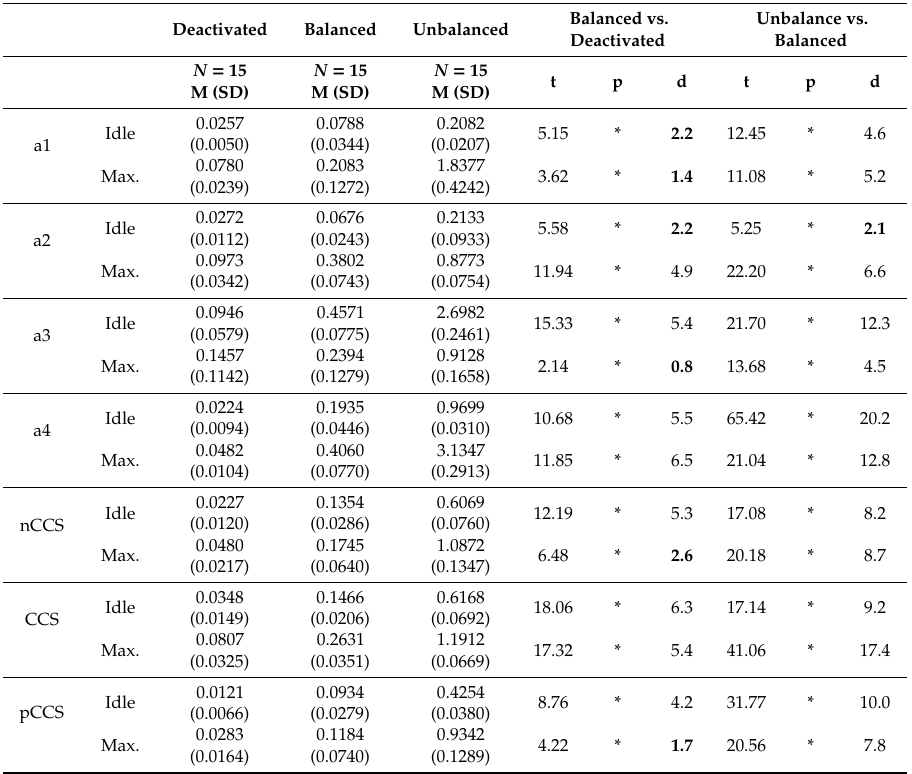
Table 4. Sample description and statistical comparison of the peak amplitudes of the chopper detected in individual spectra (a1–4), and the non-coherent (nCCS), coherent (CCS), and poly-coherent (pCCS) composite spectra, under di ff erent working conditions (deactivated, balanced and non-balanced) and at di ff erent speeds (at idle and at max. RPM). Balanced vs. Unbalance vs. Deactivated Balanced Unbalanced Deactivated Balanced